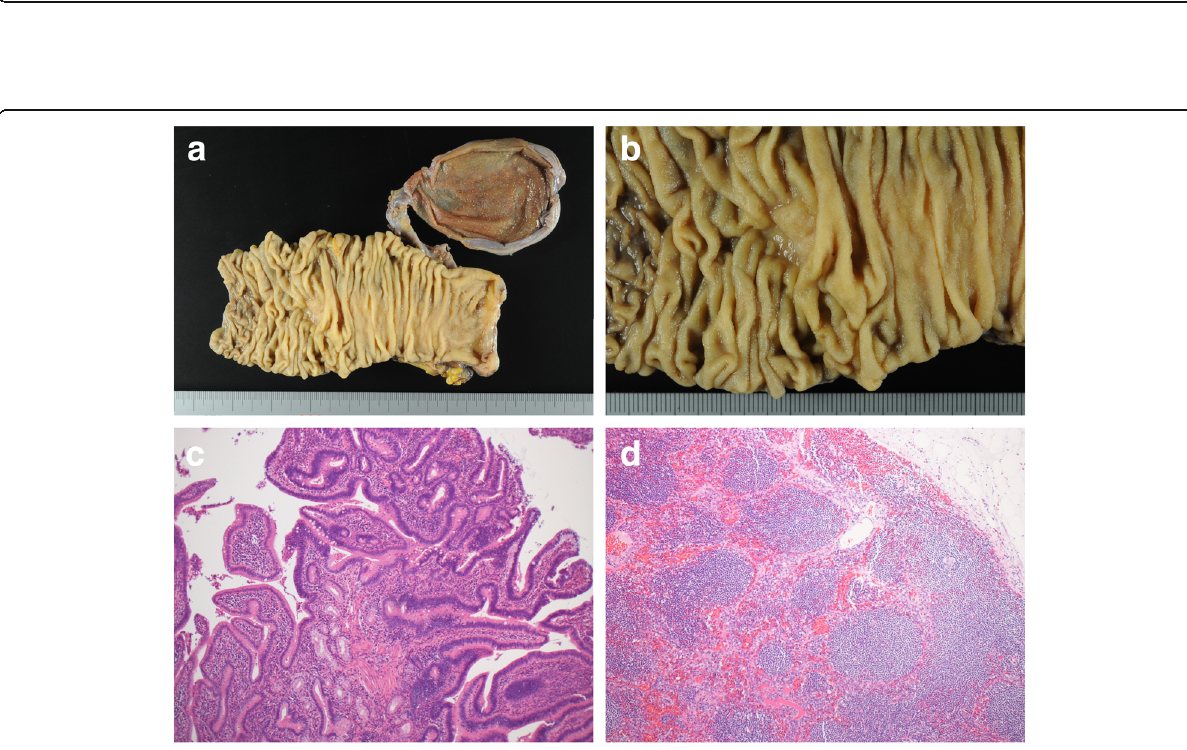
Fig. 5 a , b Macroscopic findings of the resected specimen. c Histopathological examination demonstrated ampullary mucosa with moderately atypical glands. The polarity of the nuclei was basically conserved. d Resected lymph nodes around the superior mesenteric artery consisted of hyperplasia of lymphoid follicles and necrotic tissue. There were no signs of residual tumor